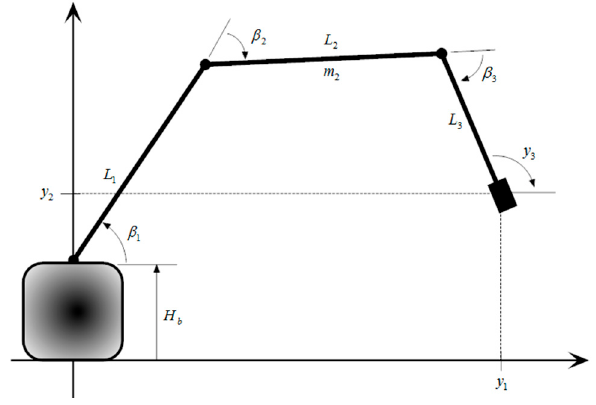
Figure 6. The considered planar robot.